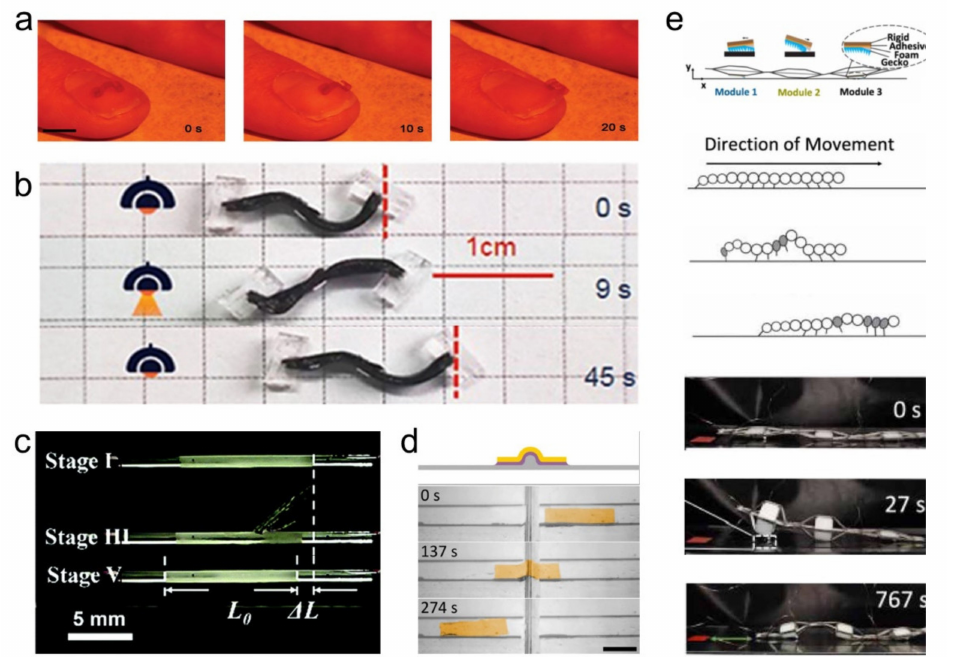
Figure 6. Worm-inspired LCE actuators: ( a ) Caterpillar robot motion on the nail of a human finger under the irradiation of 488 nm laser [85] (Reproduced with permission from Zeng, H.; Wani, O.M.; Wasylczyk, P.; Priimagi, Macromol. Rapid Commun.; Copyright 2018 John Wiley and Sons.), ( b ) The images of the serpentine robot moving under NIR light [156] (Reproduced from Ref. [156] with permission from The Royal Society of Chemistry.), ( c ) LCE capillary placed in a glass tube moving when tube heating [84] (Adapted from [84] with permission from The Royal Society of Chemistry.), ( d ) Snail-inspired LCE actuator climbing over an obstacle [29] (Reproduced with permission from Rog ó ˙z, M.; Dradrach, K.; Xuan, C.; Wasylczyk, P., Macromol. Rapid Commun.; Copyright 2019 John Wiley and Sons.), ( e ) Schematic of the LCE crawler made of three Sarrus, the robot crawling diagram modules, and representative experimental images of the caterpillar locomotion actuator [158] (Adapted with permission from Minori, A.F.; Fernandes, A.; He, Q.; Glick, P.; Adibnazari, I.; Stopol, A.; Cai, S.; Tolley, M.T., Smart Materials and Structures.; ©2020 IOP Publishing. Reproduced with permission. All rights